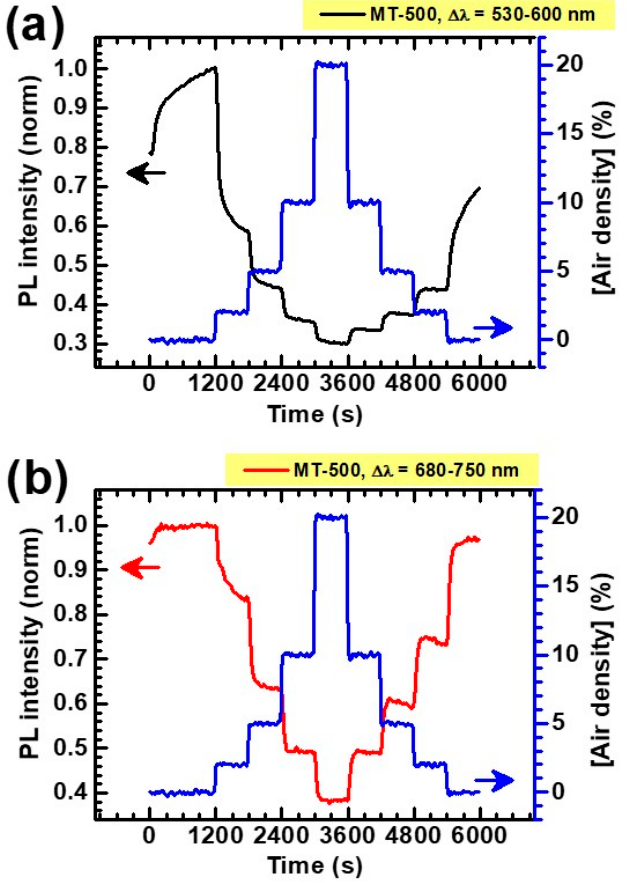
Figure 10. Time dynamics of MT-500 PL intensity integrated over the “green” and “red” wavelength intervals, defined as 530–600 nm interval ( a ) and 680–750 nm ( b ) as the sample is exposed to variable concentrations of dry air. The blue curves indicate the air concentration in percentage units.